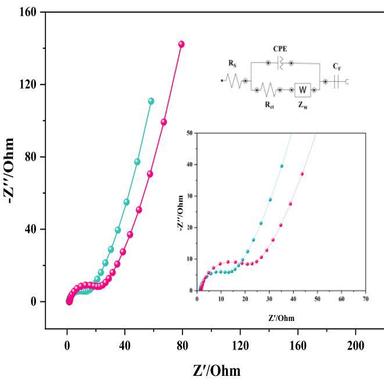
EIS Nyquist plots of FGO-Bi(BDC) and FGO-Bi(BTC).